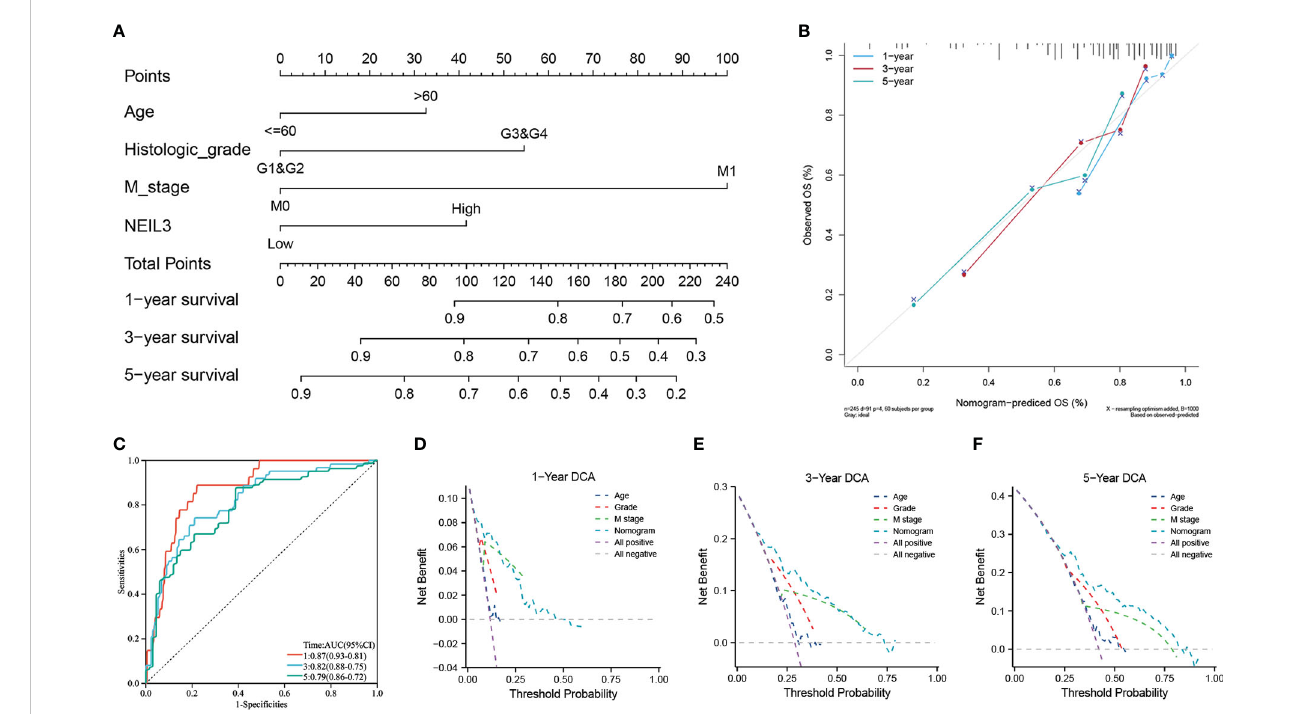
FIGURE 3 The role of NEIL3 in predicting the probability of survival in patients with KIRC. (A) A nomogram for predicting the probability of 1-, 3-, and 5- year OS. (B) Calibration curves. (C) Time dependent ROC curves. (D – F) DCA curves of 1-, 3-, and 5-year OS predicted by the nomogram and clinical